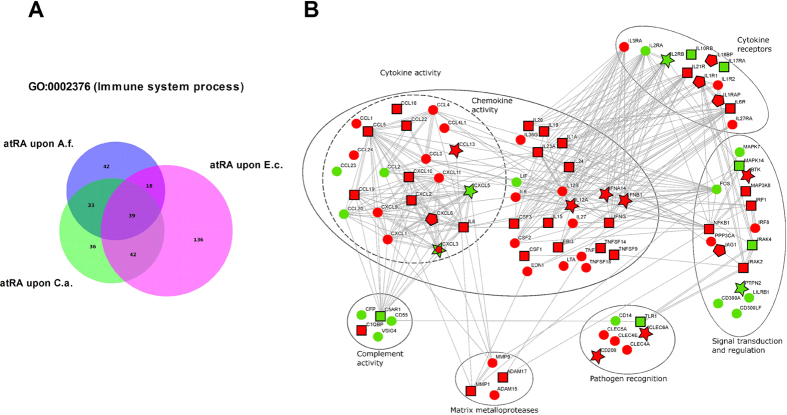
Immunomodulatory footprint of vitamin A during infection.AtRA shows a pathogen-specific regulatory role on immune-relevant genes leading to an overall down-regulation of cytokines, chemokines and matrix metalloproteases and an up-regulation of complement-related genes. (A) Venn diagram showing the overlap and amount of atRA-regulated immune-relevant genes (GO:0002376) in each of the infections analysed: A. fumigatus (blue), C. albicans (green) and E. coli (magenta). (B) Network based on experimental and database-derived knowledge (edges) generated with the STRING database. ○ atRA regulated these genes in at least two of the pathogenic infection settings;  atRA-regulated genes during C. albicans infection; □ atRA-regulated genes during E. coli infection;  atRA-regulated genes during A. fumigatus infection; red: down-regulation, green: up-regulation.